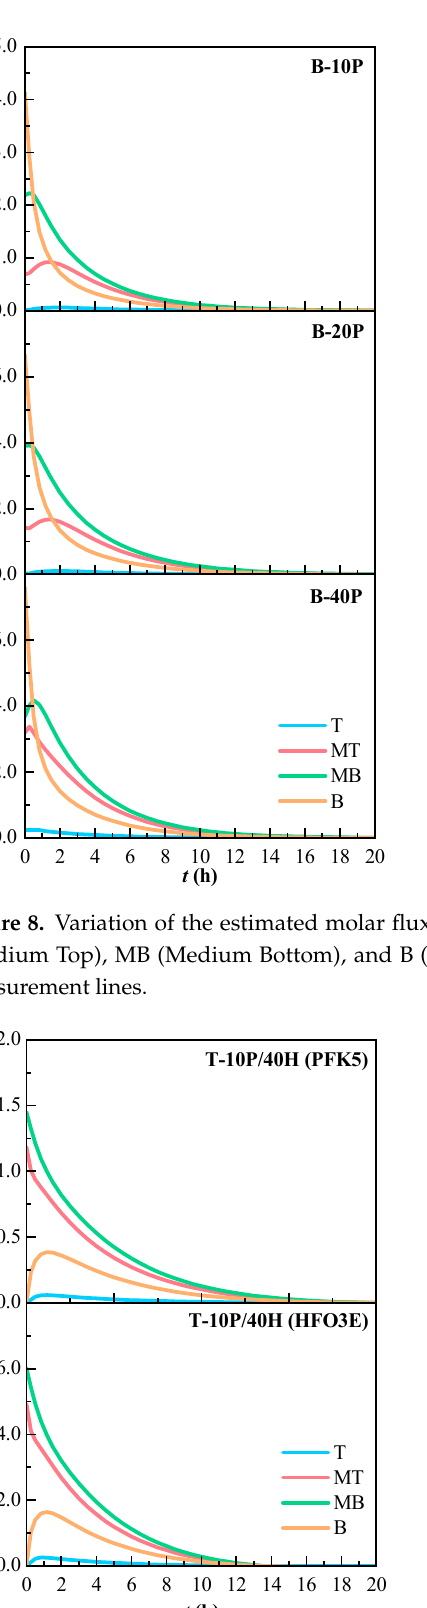
Figure 7. Variation of the estimated convection velocity ( V ) of the components of the ternary mix- ture over time. T (Top), MT (Medium Top), MB (Medium Bottom), and B (Bottom) correspond to the different heights of the measurement lines.